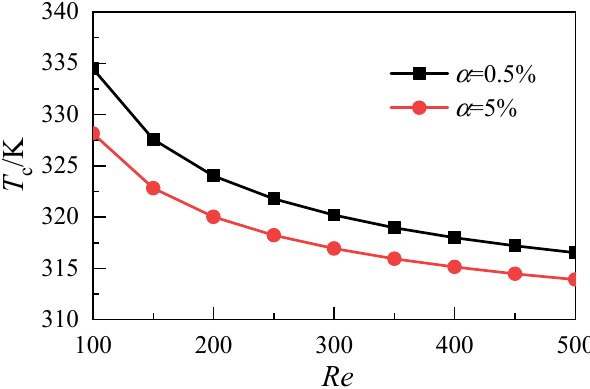
Figure 4. Average temperature distributions of the fluid-solid surface.